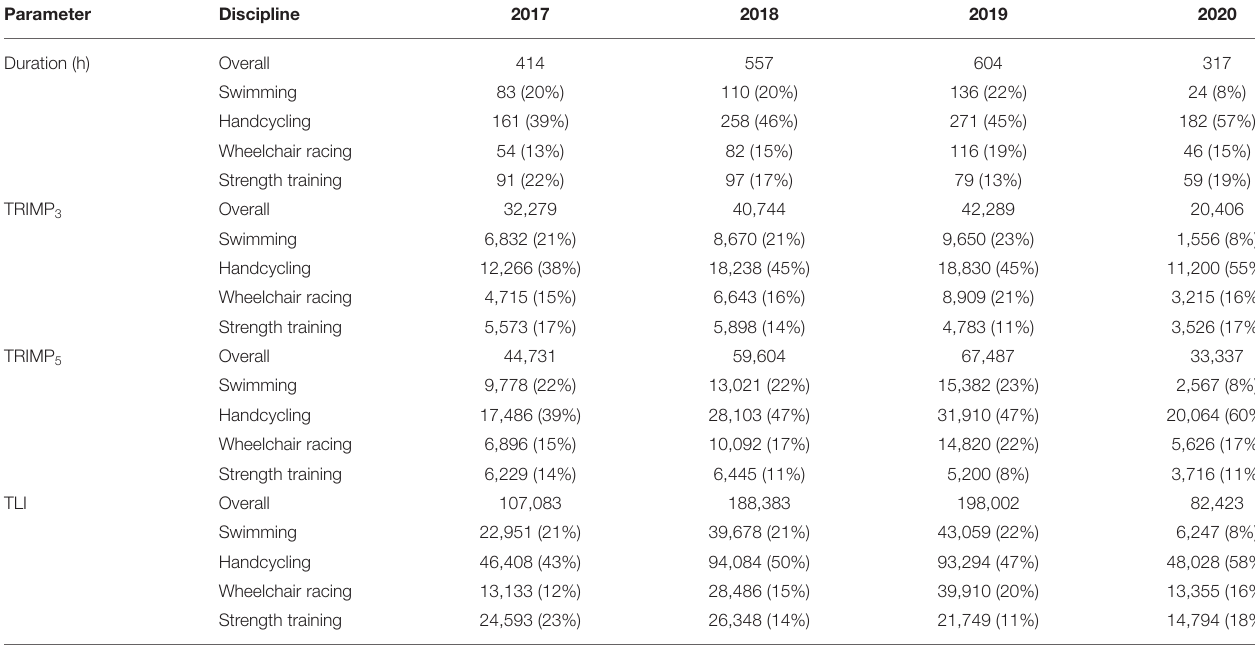
TABLE 1 | Yearly and discipline-specific training load (TL) during the Olympiad.